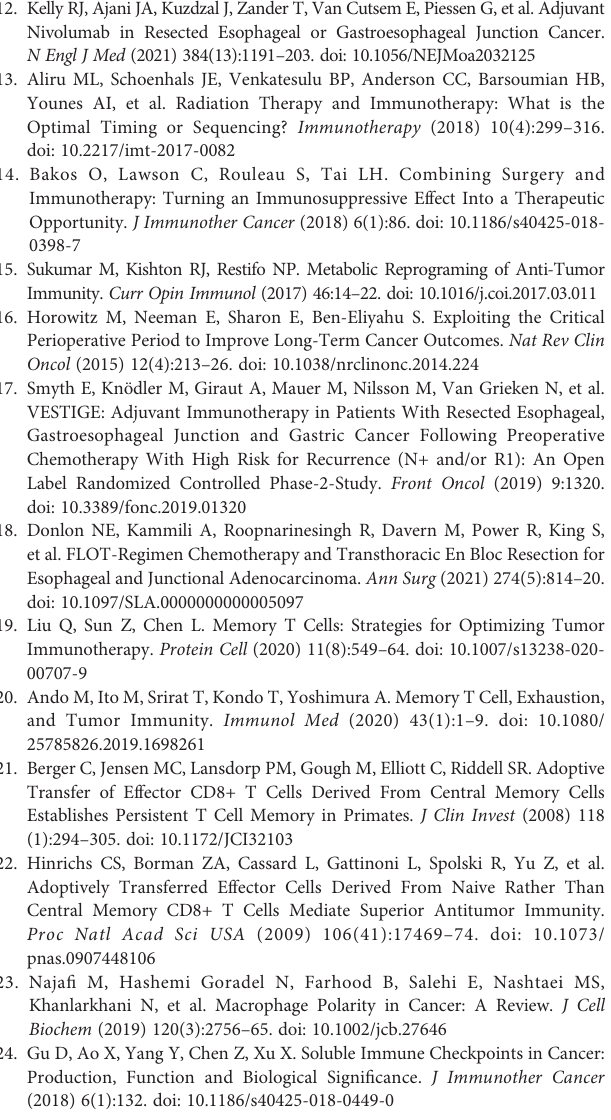
Supplementary Figure 2 | Expression of activation markers on CD4 T helper cells (A) and CTLs (B) in circulation categorised by treatment type. Frequency of CD4 T helper (C) and CTL (D) differentiation states in circulation categorised by treatment received. Green diamond: no neoadjuvant treatment received (n=1), blue circle: FLOT (n=7), red square: CROSS (n=2) and orange triangle: FOLFOX (n=1). Supplementary Figure 3 | Frequency of circulating cell types categorised by treatment type. (A) . Expression of ICs on the surface of circulating CD4 T helper cells (B) and CTLs (C) as well as expression of DAMPs on CD4 T helper cells (D) and CTLs (E) categorised by treatment received. Green diamond: no neoadjuvant treatment received (n=1), blue circle: FLOT (n=7), red square: CROSS (n=2) and orange triangle: FOLFOX (n=1). Supplementary Figure 4 | Levels of circulating immunomodulatory and pro- angiogenic mediators categorised by treatment type. Soluble levels of circulating immunostimulatory mediators (A) and pro-angiogenic factors (B) categorised by treatment received. Green diamond: no neoadjuvant treatment received (n=1), blue circle: FLOT (n=7), red square: CROSS (n=2) and orange triangle: FOLFOX